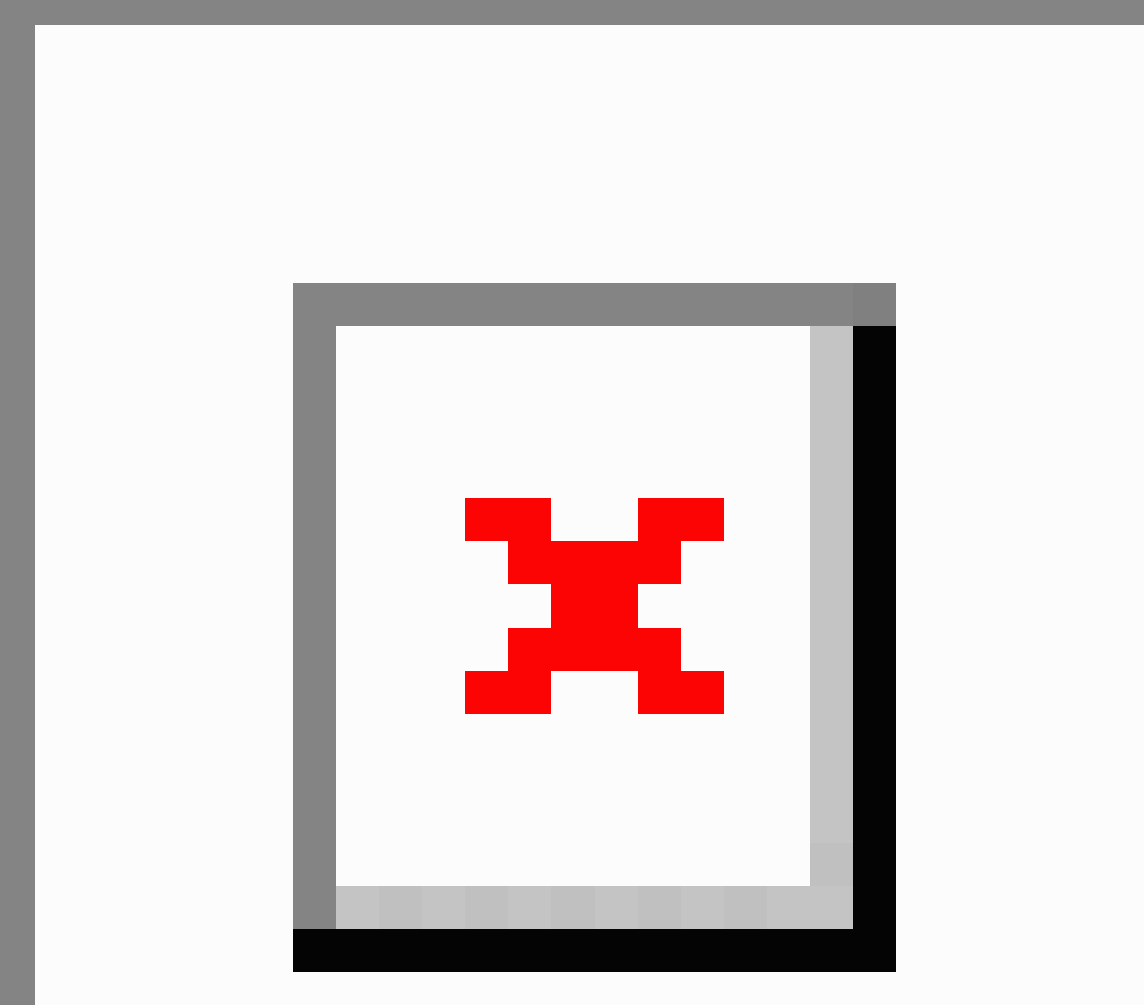
Figure 2. Information dissemination potential for each professional physicians group - American Medical Association (AMA), American Academy of Family Physicians (AAFP), American Academy of Pediatrics (AAP), and American College of Physicians